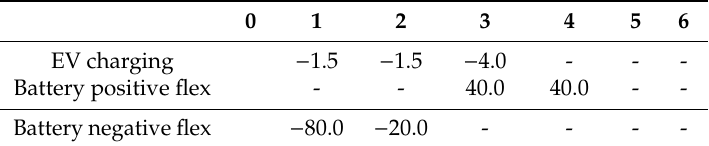
Table 3. Flexibility estimates